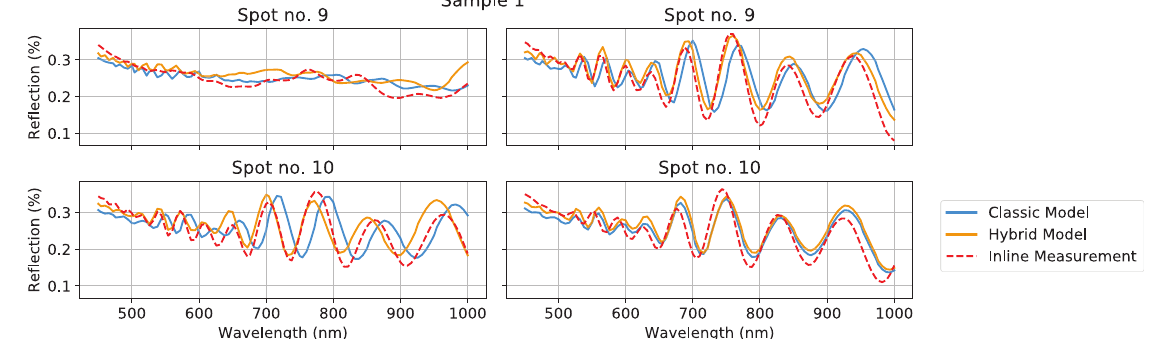
Fig. 10. All four re fl ection measurement curves considered for the thickness prediction together with the recreated re fl ection curves calculated with the predicted layer parameters from the classic and the